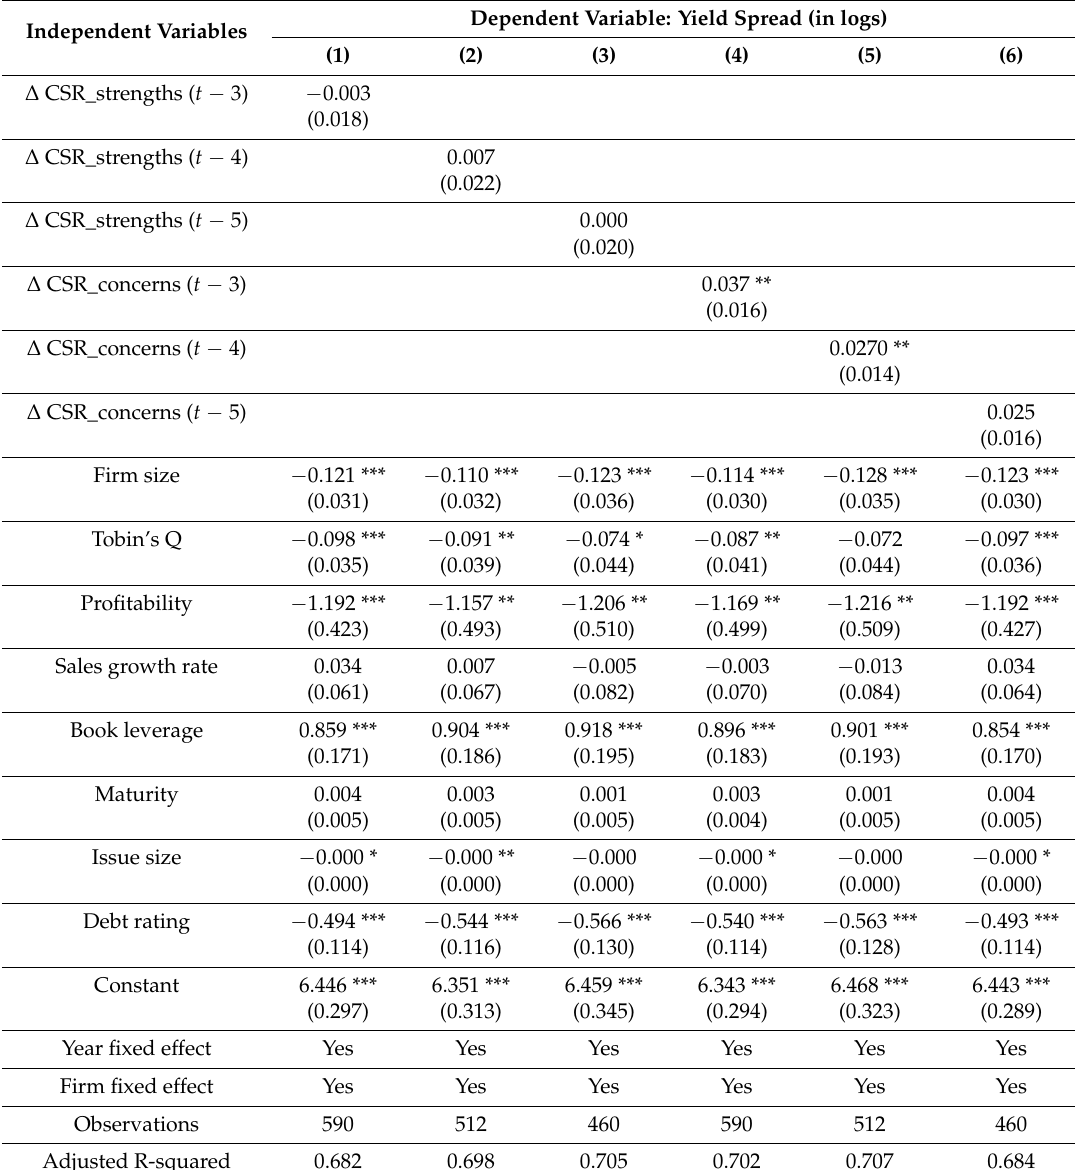
Table 6. Time-series changes in CSR profiles and bond yield spread at issuance under Rule 144A. Independent